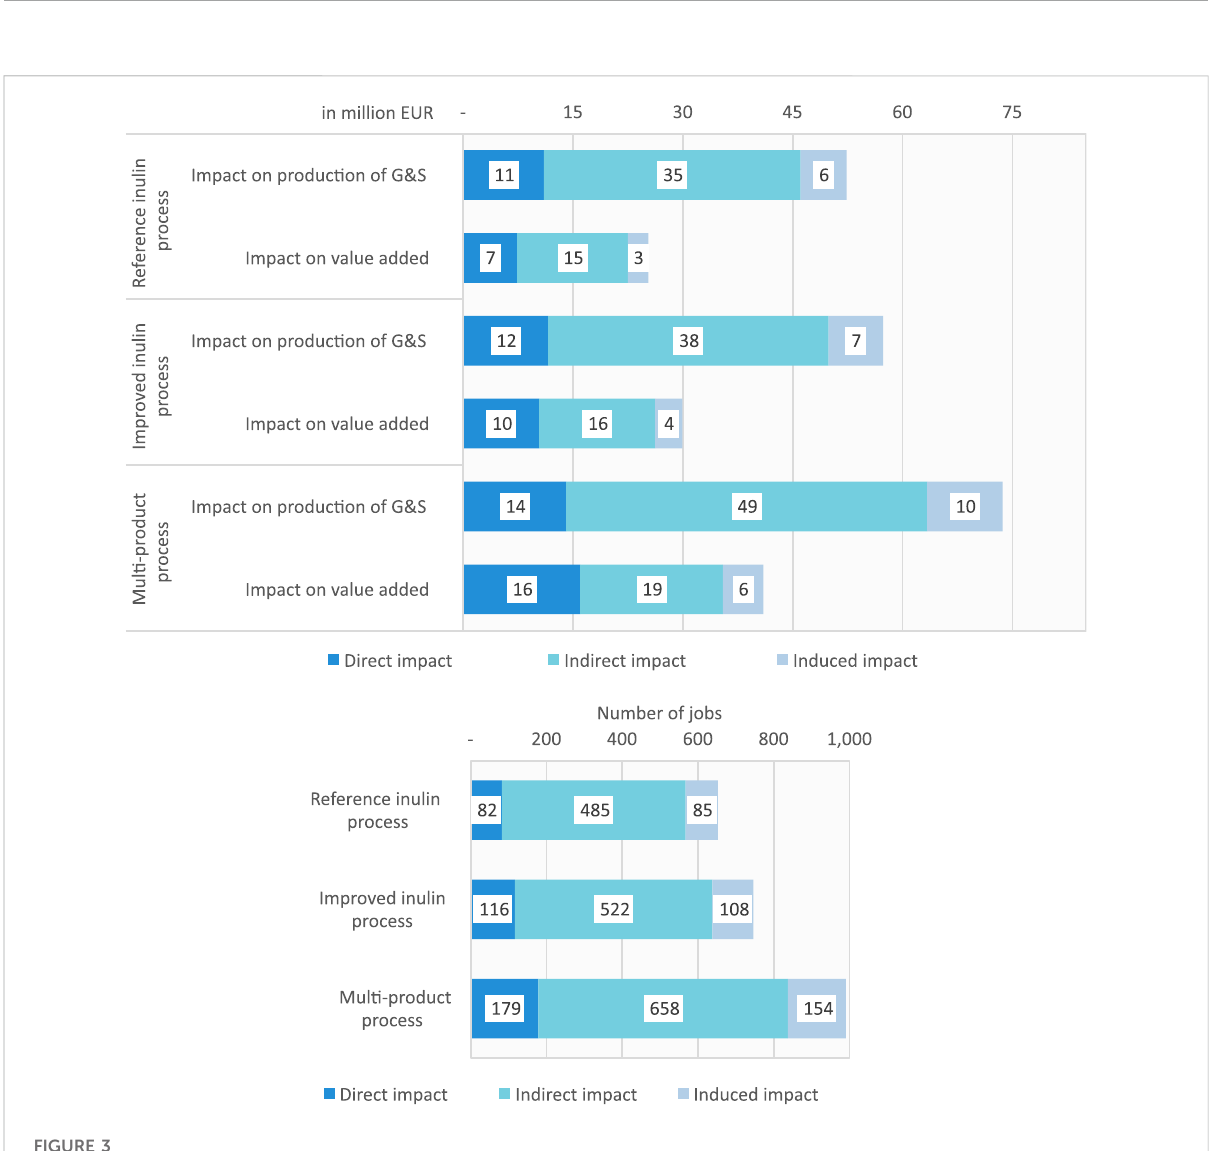
FIGURE 3 Direct, indirectandinducedimpactspercategory(value added[M € ],production ofgoodandservices(G&S)[M € ],jobs[number])andscenario.